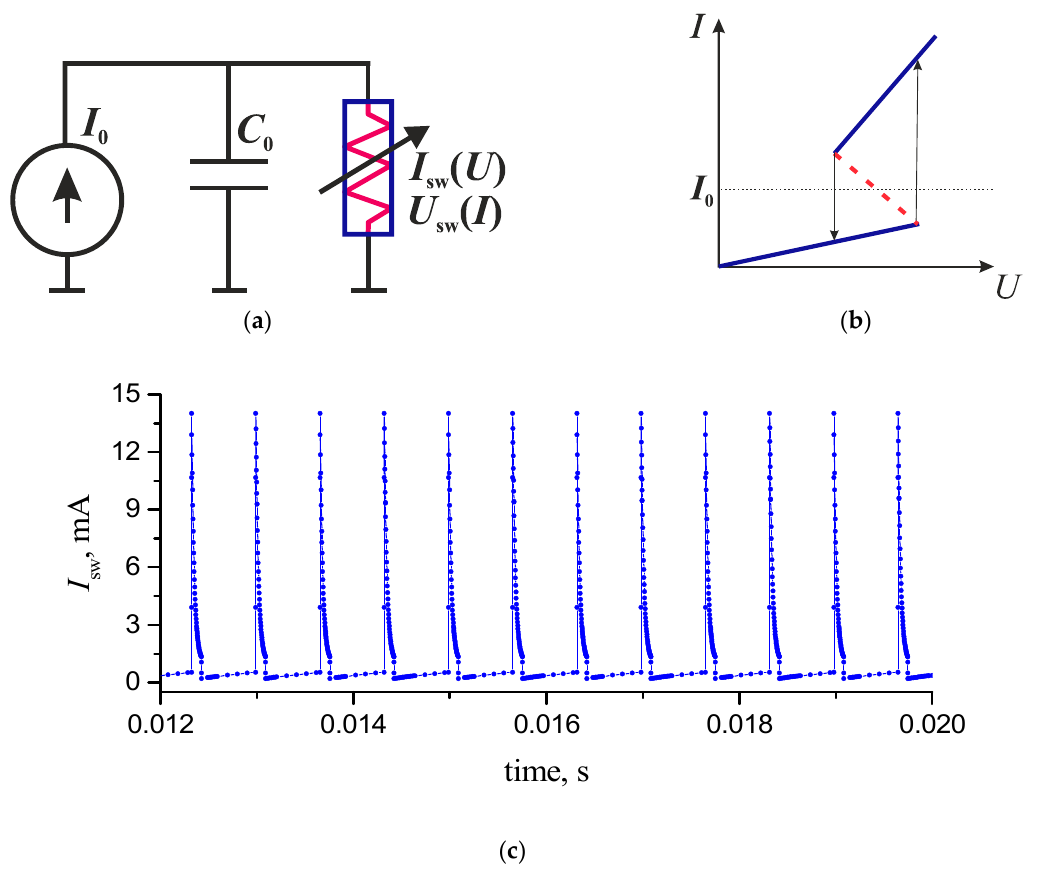
Figure 5. Relaxation oscillator circuit ( a ) and the load characteristic with the operating point in the NDR region ( b ). Current oscillations at I 0 = 1 mA, C 0 = 100 nF, and VO 2 switch (for the I–V characteristic with unstable NDR, see Figure 2a) ( c